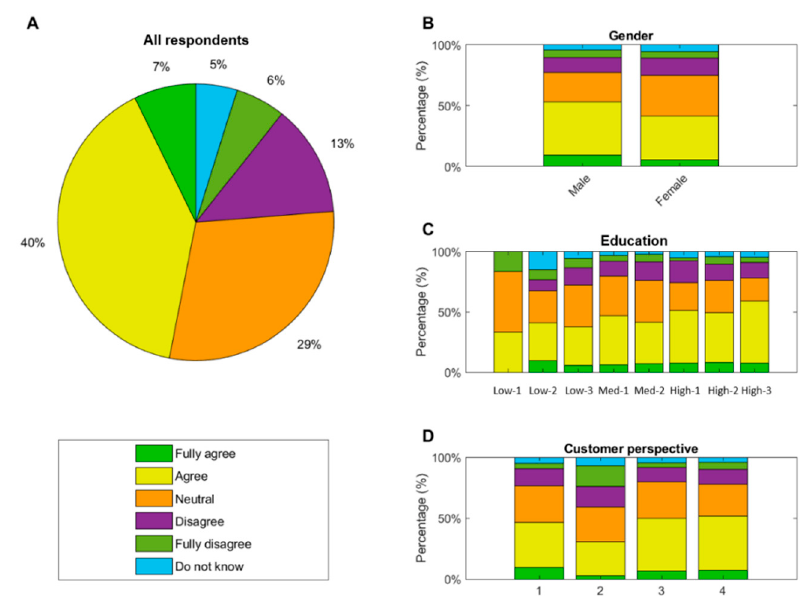
Figure 3. Level of agreement with the statement: ‘tap water containing very small amounts of non-natural substances is safe to drink as long as the amount falls within the legal standards’. Graph ( A ): For all people questioned. Graph ( B ): How gender affects the customer perspectives. Graph ( C ): How the level of education (low, medium or high) influences customer perspectives (low-1 “primary